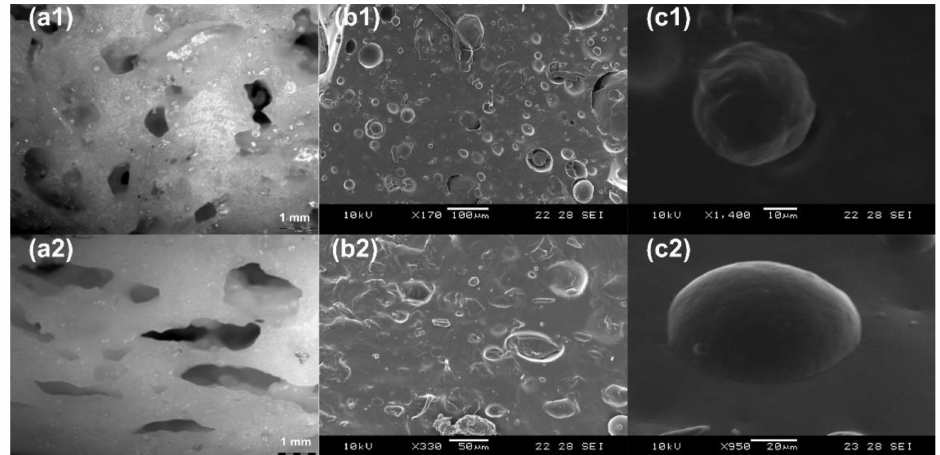
Figure 4. Pores and PCL inclusions in (610:70:50) sample. ( a1 ): Pores in original sample (optical microscope); ( a2 ): elliptical pores after programming (40% compression); ( b1 ): circular PCL inclusions in original sample (SEM); ( b2 ): elliptical PCL inclusions in 40% programmed sample; ( c1 ): zoom-in view of one typical circular PCL inclusion in original sample (SEM); ( c2 ): zoom-in view of one typical elliptical PCL inclusion in 40% programmed sample. Accelerating voltage of SEM: 5 kV.